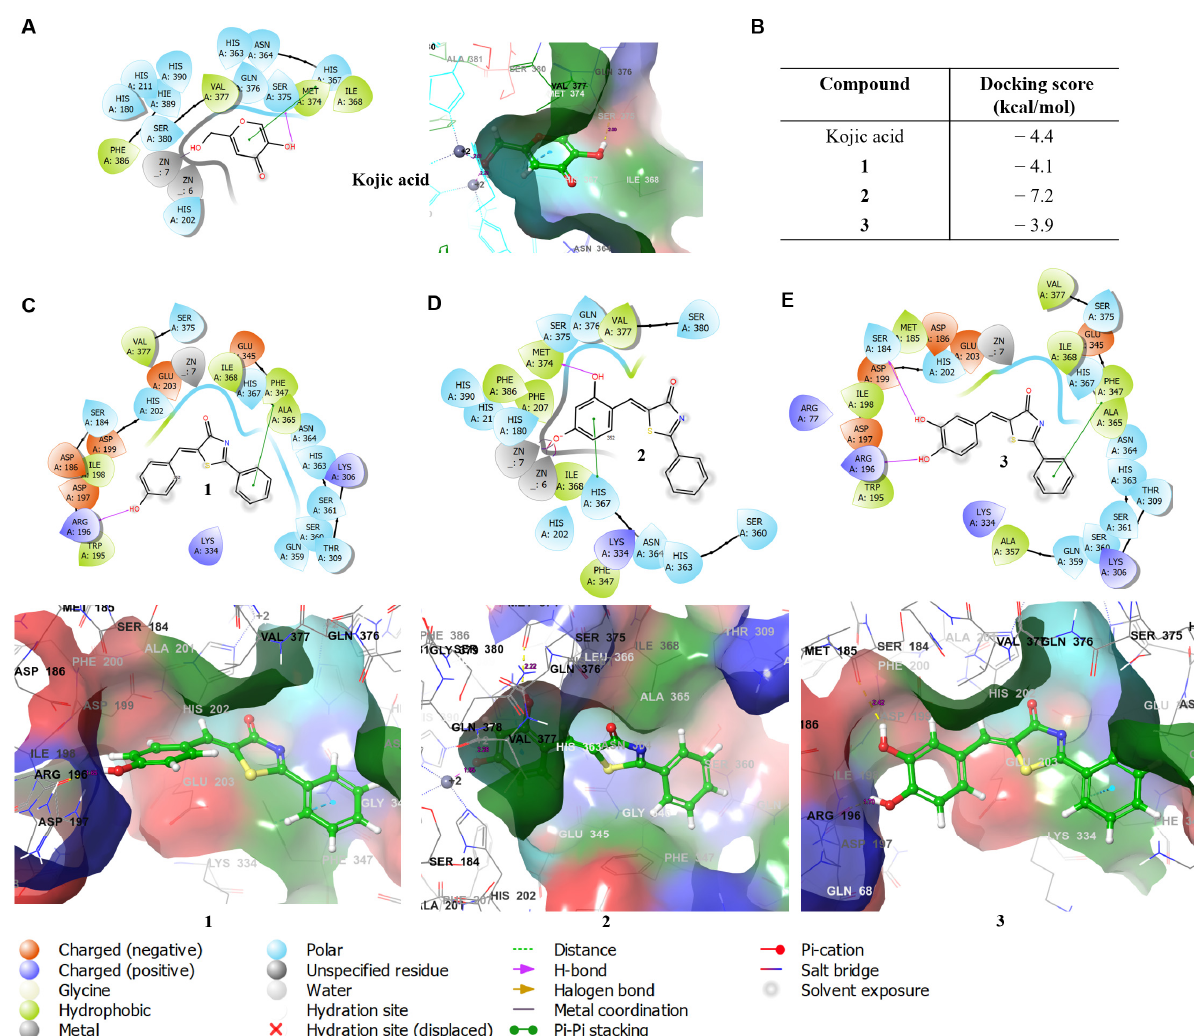
Figure 5. Docking scores and in silico docking simulation results of kojic acid, ( Z )-BPT derivatives 1 – 3 , and the human tyrosinase homology model using Schrodinger Suite. ( A ) Kojic acid, ( B ) docking scores, ( C ) ( Z )-BPT 1 , ( D ) ( Z )-BPT 2 , and ( E ) ( Z )-BPT 3 .